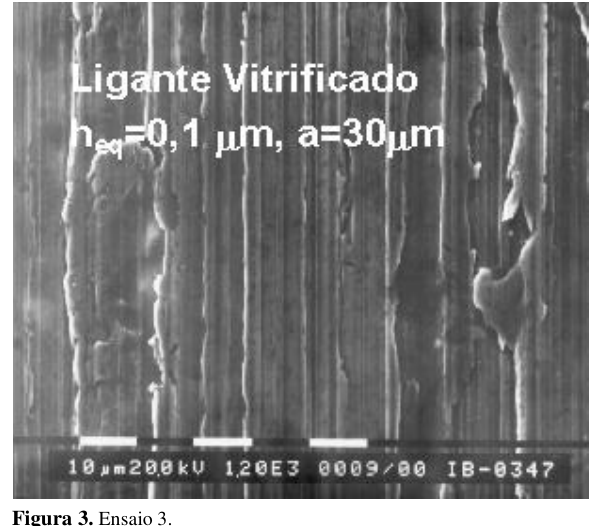
Figura 3. Ensaio